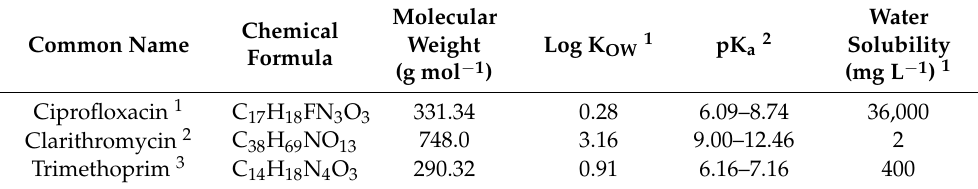
Table 1. Main characteristics of the three antibiotics